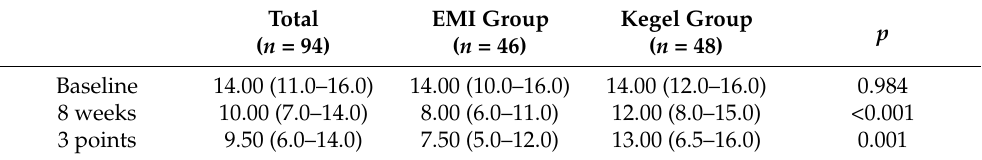
Table 4. Point values of the ICIQ-UI SF questionnaire with its respective interquartile range (25th and 75th percentile) in the study population and between the observed groups throughout the follow-up period.